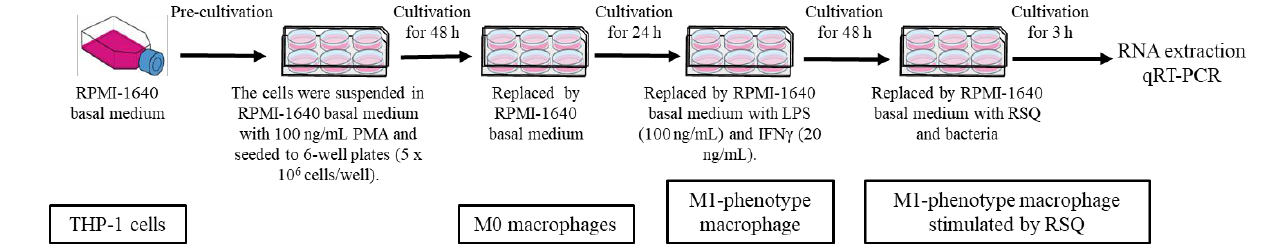
Figure 1. Schedule of stimulation with RSQ and bacteria in M1-phenotype macrophage cell cultures.